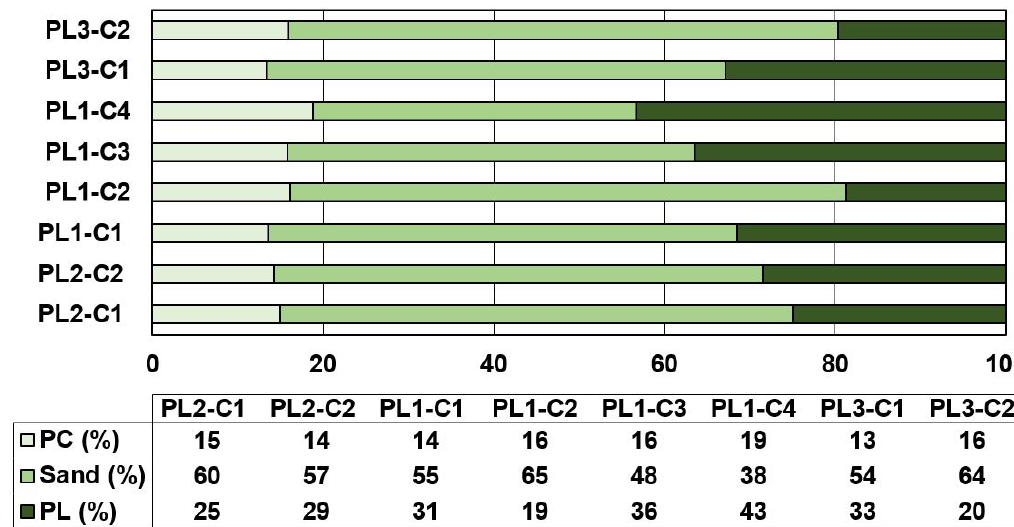
Figure 3: Volume percent of Portland cement, sand, and type of PL in the